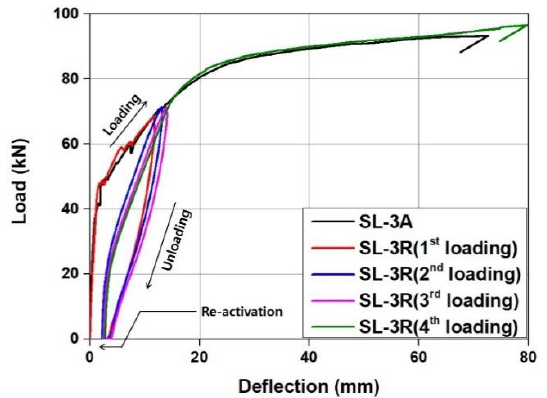
Figure 14. Comparison of load – deflection relationship between SL-3A and SL-3R.